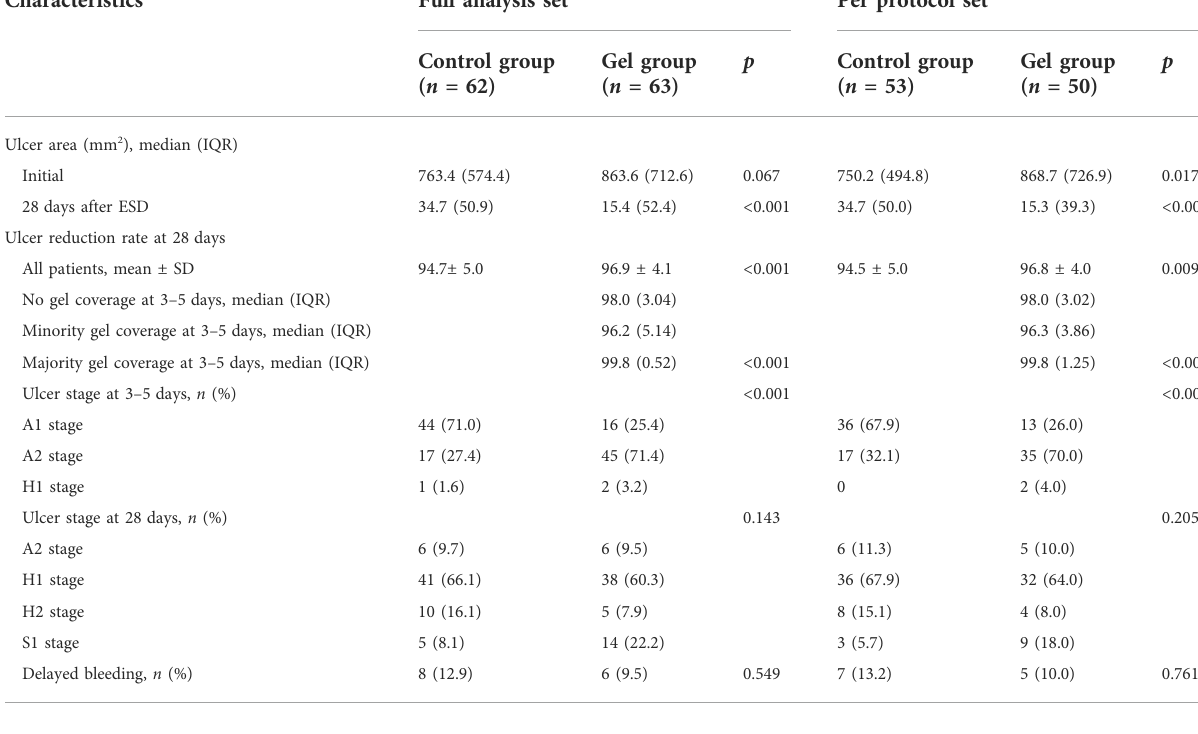
TABLE 2 Ulcer healing at 3 – 5 days and 28 days after endoscopic submucosal dissection (ESD).